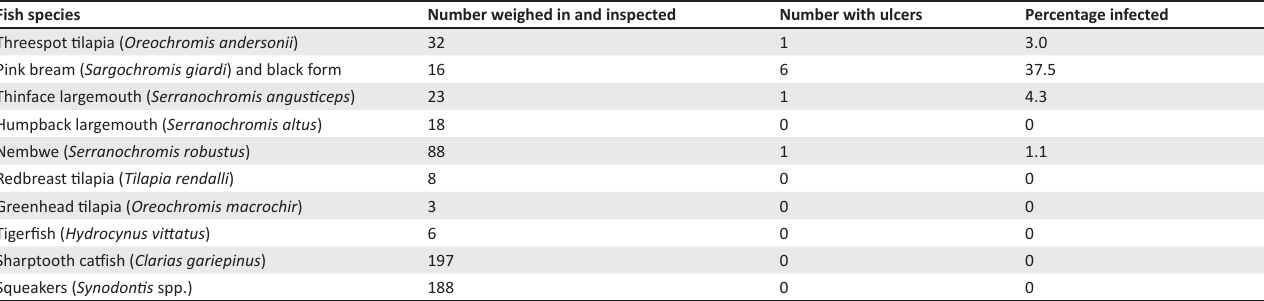
Sharptooth catfish ( Clarias gariepinus )